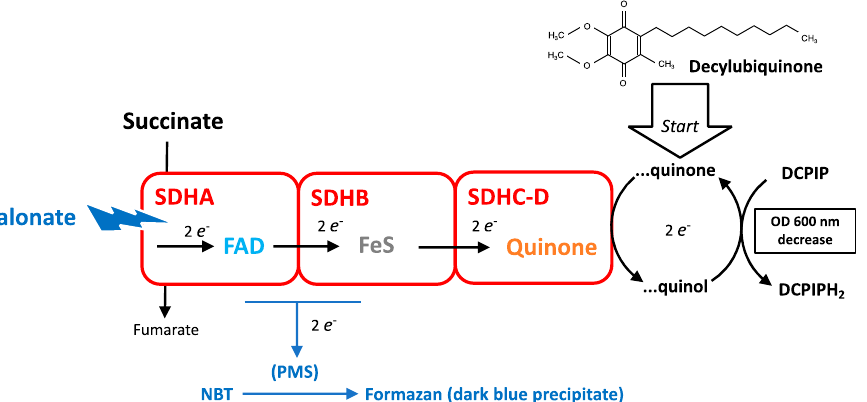
Figure 4. Measurement of SDH activity. Subunits A, B, and C-D are schematized by blocks; their most relevant redox cofactors are indicated: FAD, Iron sulfur centers (FeS), and quinone. Interception of electrons by acceptors used to assess SDH activity is shown. PMS is abbreviation for phenazin methosulfate, and NBT for nitro blue tetrazolium. With dichlorophenol-indophenol (DCPIP), the reaction is initiated by the addition of the redox intermediate decylubiquinone. Malonate, a competitive inhibitor for succinate, is used to check for the specificity of the reaction.